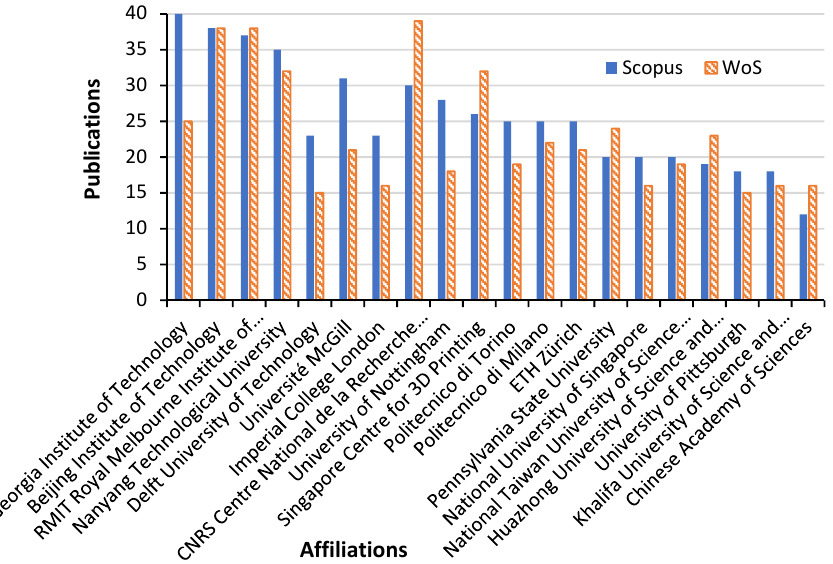
Figure 15. Publication affiliation for “additive manufacturing on lattice structure” research (data retrieved from Scopus and WoS on 20 June 2022). Table 3. Comparisons on publication affiliation for “additive manufacturing on lattice structure” research (data retrieved from Scopus and WoS on 20 June 2022).